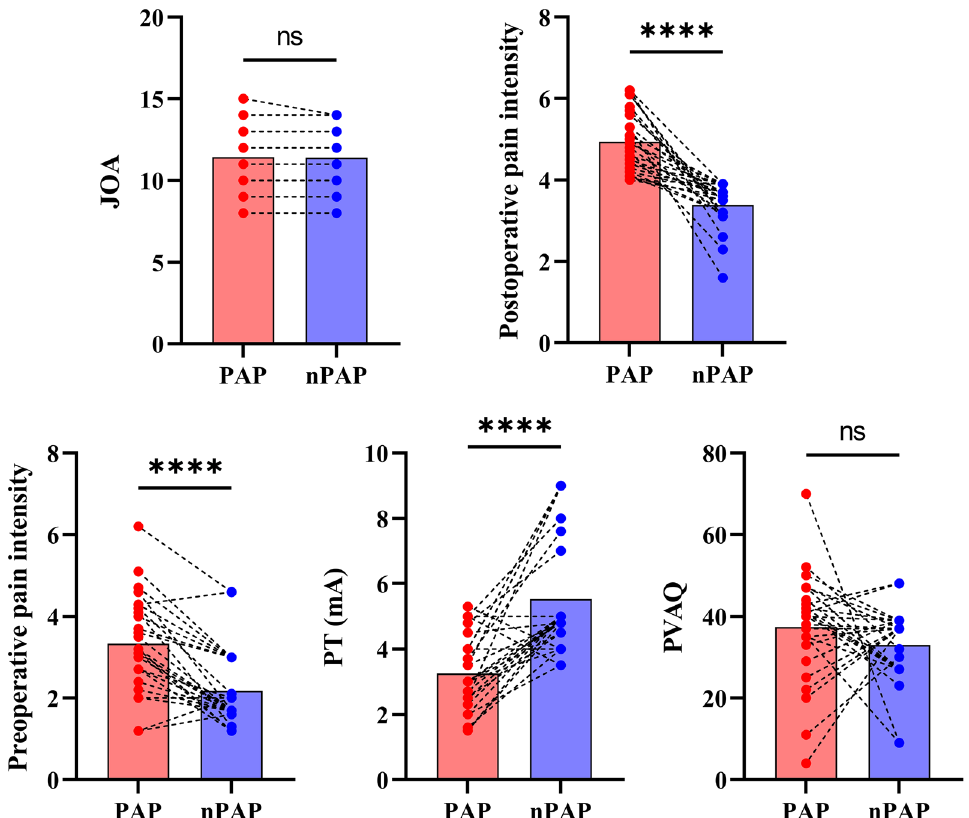
Fig. 2 Clinical metrics differences between DCM patients have postoperative axial pain (PAP) and no postoperative axial pain (nPAP) while matching the Japanese Orthopedic Association score. PT: Pain Threshold; PVAQ: Pain Vigilance and Awareness Questionnaire; JOA: Japanese Orthopedic Association